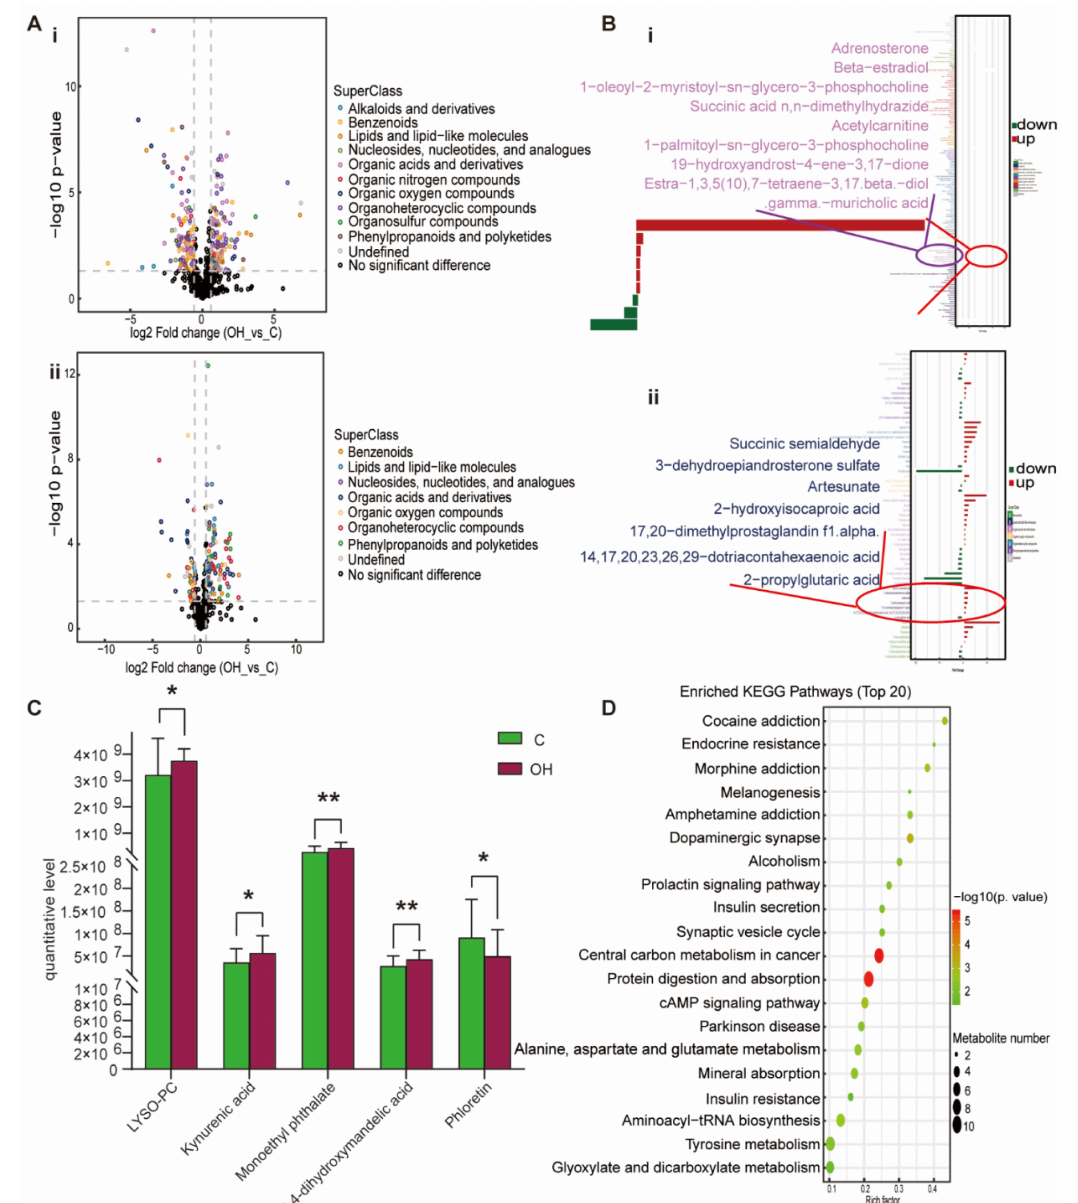
Figure 6. Analysis of differential metabolites between OH vs. C. ( A ) Volcano plot of positive (i) and negative (ii) ion modes. Points on the right half of volcano plot represent up-regulated metabolites satisfying FC > 1.5, p < 0.05, and the points on the left half represent down-regulated metabolites satisfying FC < 0.67, p < 0.05, and black points on behalf of non-differential metabolites. ( B ) (i,ii) Bar graphs of the positive and negative ion modes. The abscissa indicates the fold change (FC). Red bars on behalf of up-regulated metabolites satisfying FC > 1, p < 0.05, green bars on behalf of down-regulated metabolites satisfying FC < 1, p < 0.05. The ordinate represents significantly distinctive metabolites. Local enlarged view for lipids and lipid-like molecules. ( C ) LYSO-PC: 1- palmitoyl-sn-glycero-3-phosphocholine. Differential metabolites unique to the to the OH group. (* p < 0.05, ** p < 0.01). ( D ) KEGG pathway enrichment bubble diagram. The vertical axis represents the KEGG metabolic pathway, and the horizontal axis represents the rich factors (the ratio of the number of differential metabolites to the number of annotated metabolites in this pathway). The redder the circle color, the smaller the p -value of enrichment analysis and the higher the channel significance